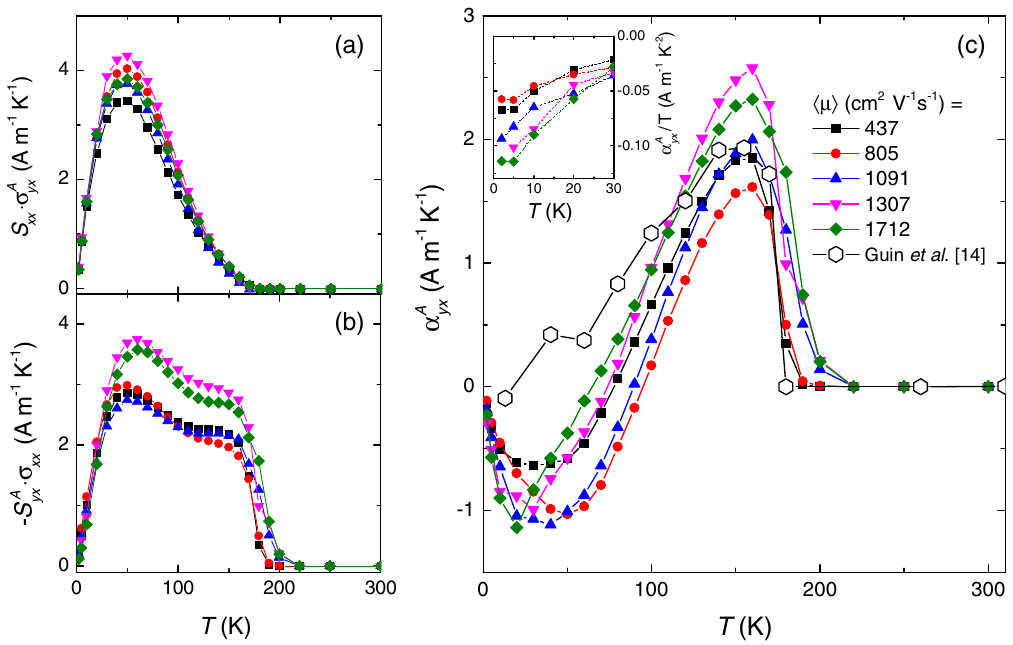
FIG. 6. Anomalous off-diagonal component of the thermoelectric tensor α A yx . (a),(b) Temperature dependence of two products S xx σ A yx and − S A yx σ xx . The total α A yx is the difference between these two large signals. (c). The anomalous thermoelectricity coefficient α A yx in the five samples. Also shown is the data reported by Guin et al. [14]. Note the absence of the negative slope resolved here in their data. The inset shows the α A yx =T at low temperatures to show the magnitude of the asymptotic negative slope in different